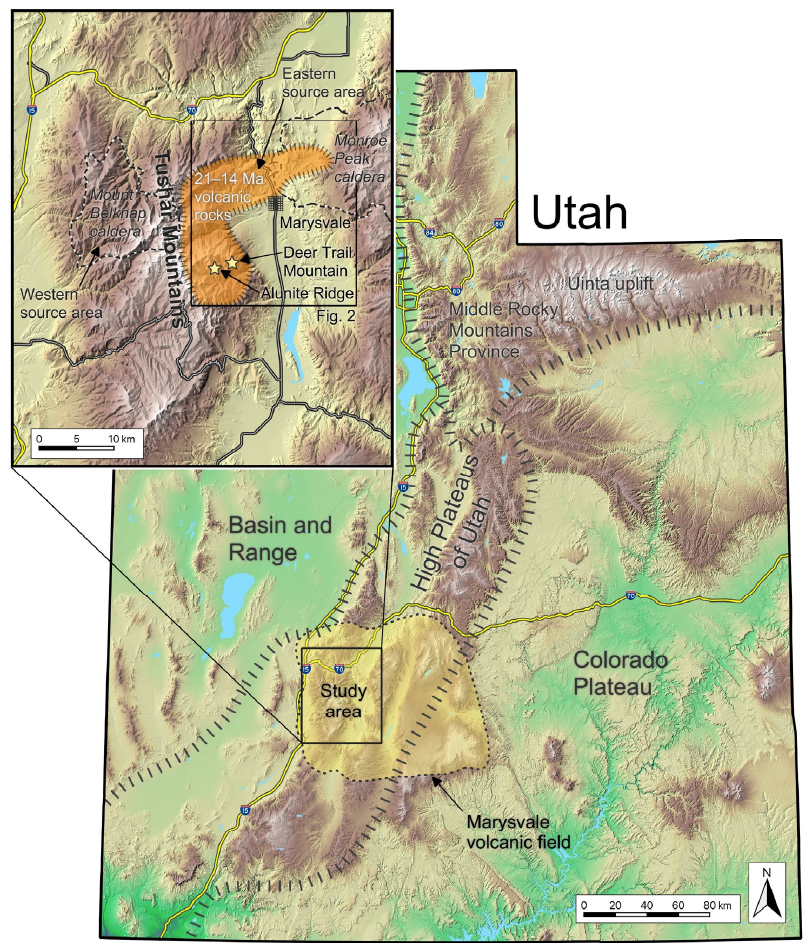
Figure 1. Map of Utah with the location of the Marysvale volcanic field (yellow region with dotted border) highlighted relative to the major physiographic provinces in the region (approximate boundaries shown by hashed lines). The study area is shown in the inset with the boundaries of the Monroe Peak and Mount Belknap calderas indicated by the dashed lines and the approximate region where 21–14 Ma volcanic rocks are exposed indicated by the orange region with the hashed outline. The area of Figure 2 is shown in the inset.